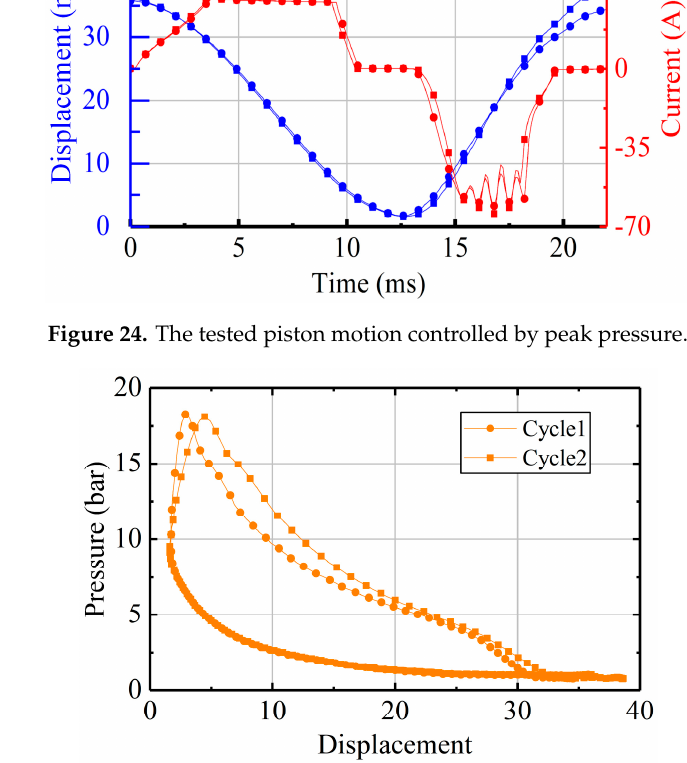
Figure 24. The tested piston motion controlled by peak pressure.